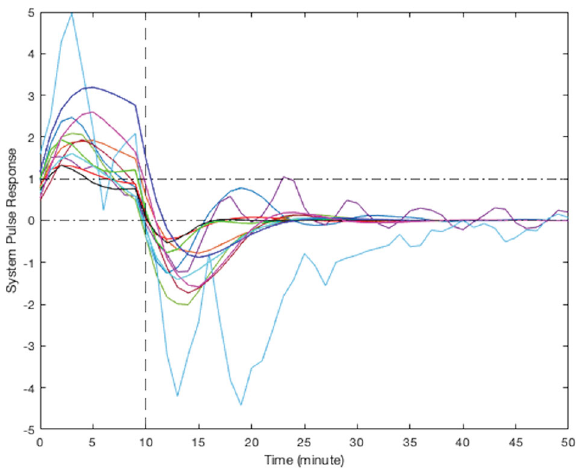
Fig. 5 Pulse response for participants in cluster 1, instant increase followed by a sharp decrease in smoking odds. The vertical line at the 10-min mark on the x -axis re fl ects the time when the stress probability returned to zero.